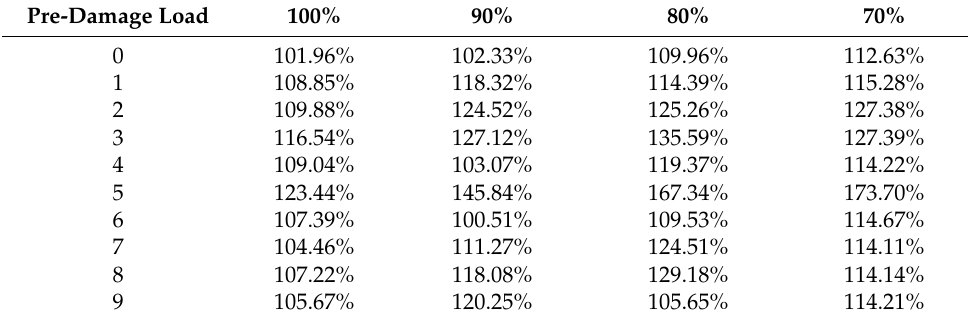
Table 7. Recovery rate of compressive strength after 7 d of curing.